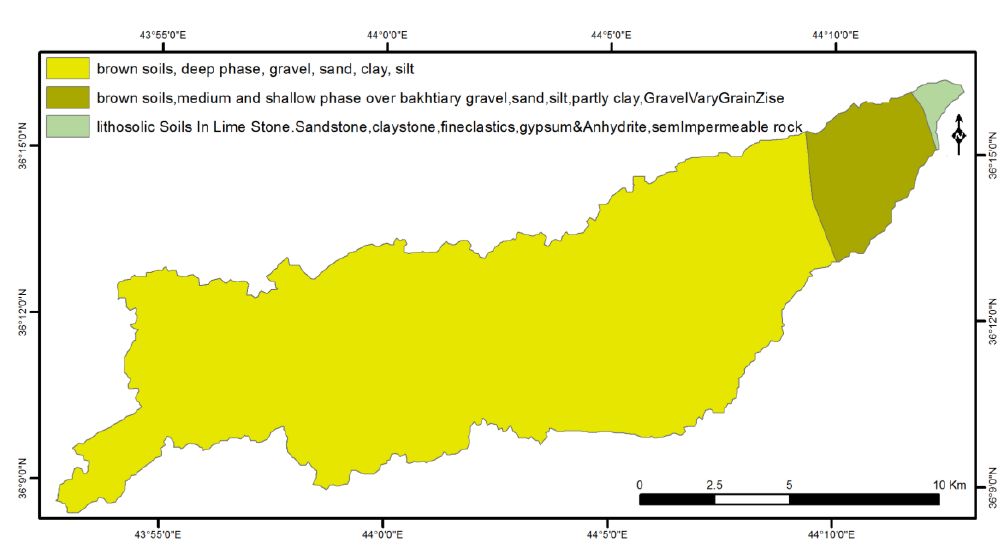
Figure 2. Soil map of the watershed.